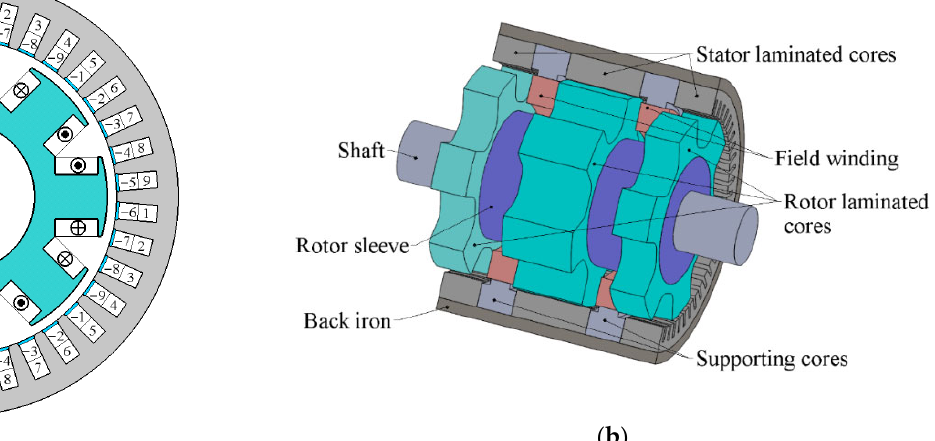
Figure 1. Representation of the motor design: ( a ) DC excited wound rotor synchronous motor (WRSM); the stator slot, circled in red oval, is shown in more detail in Figure 2; ( b ) synchronous homopolar motor (SHM).